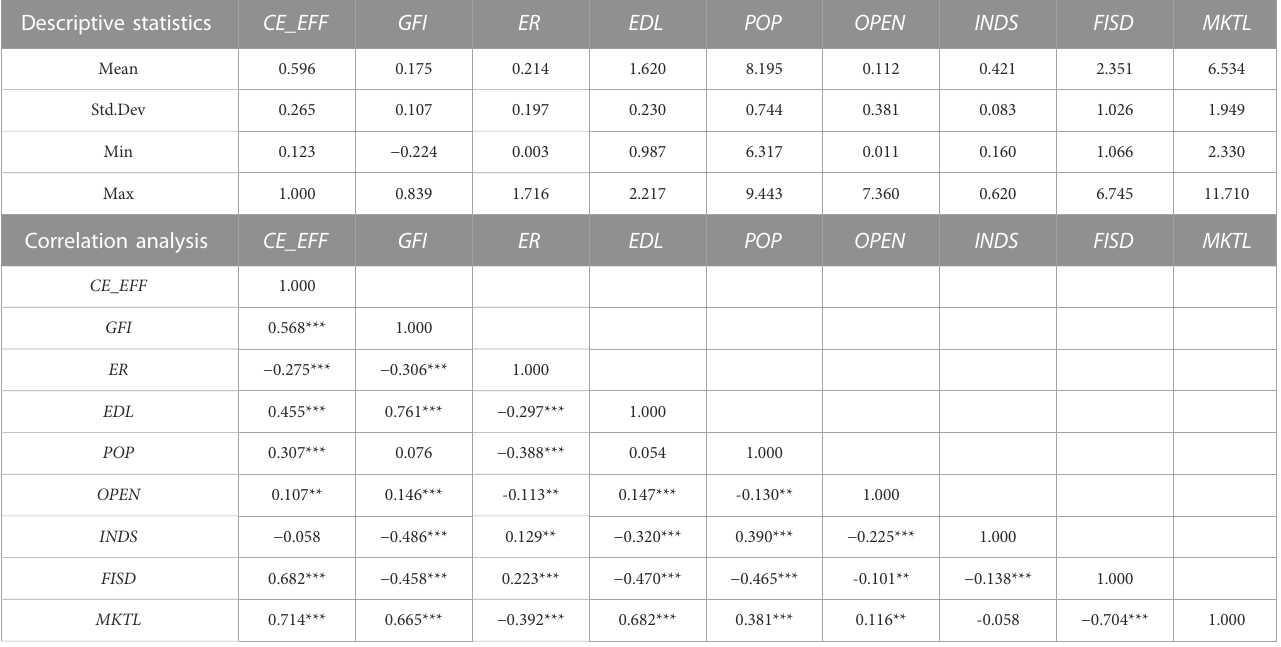
TABLE 2 Descriptive statistics and correlation analysis of variables. Descriptive